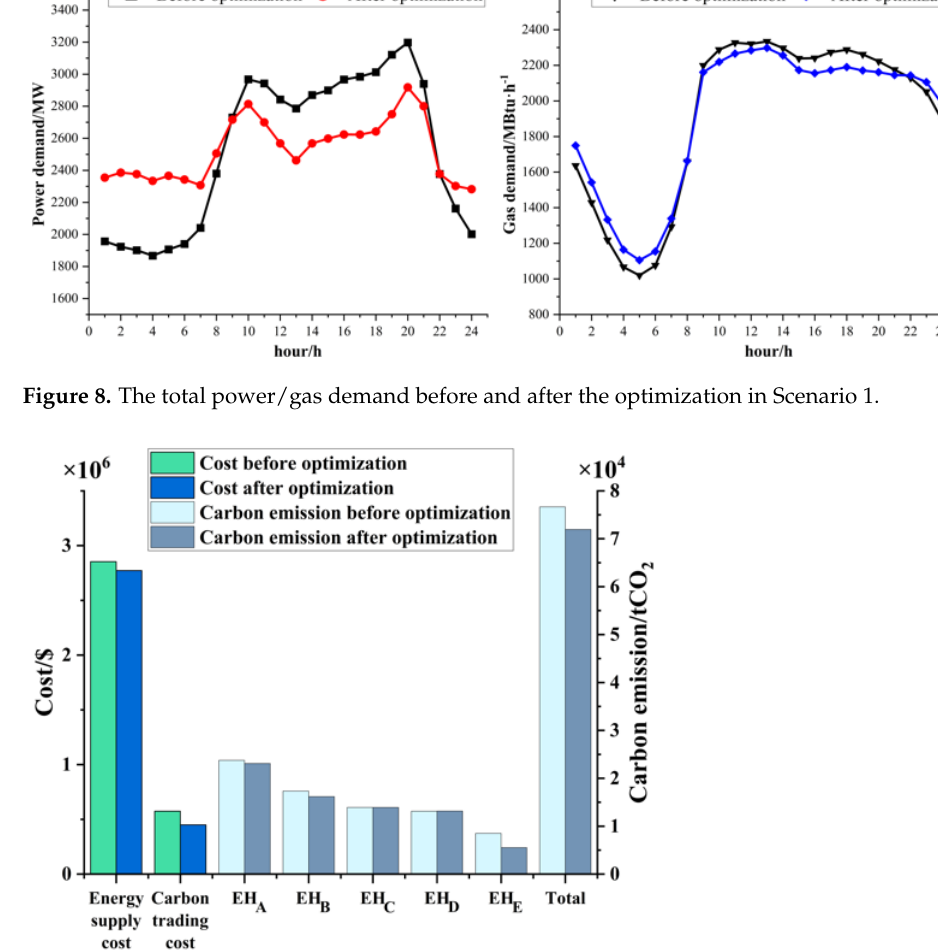
Figure 9. The energy supply cost, carbon trading cost, and carbon emissions of each EH before and after the optimization in Scenario 1.